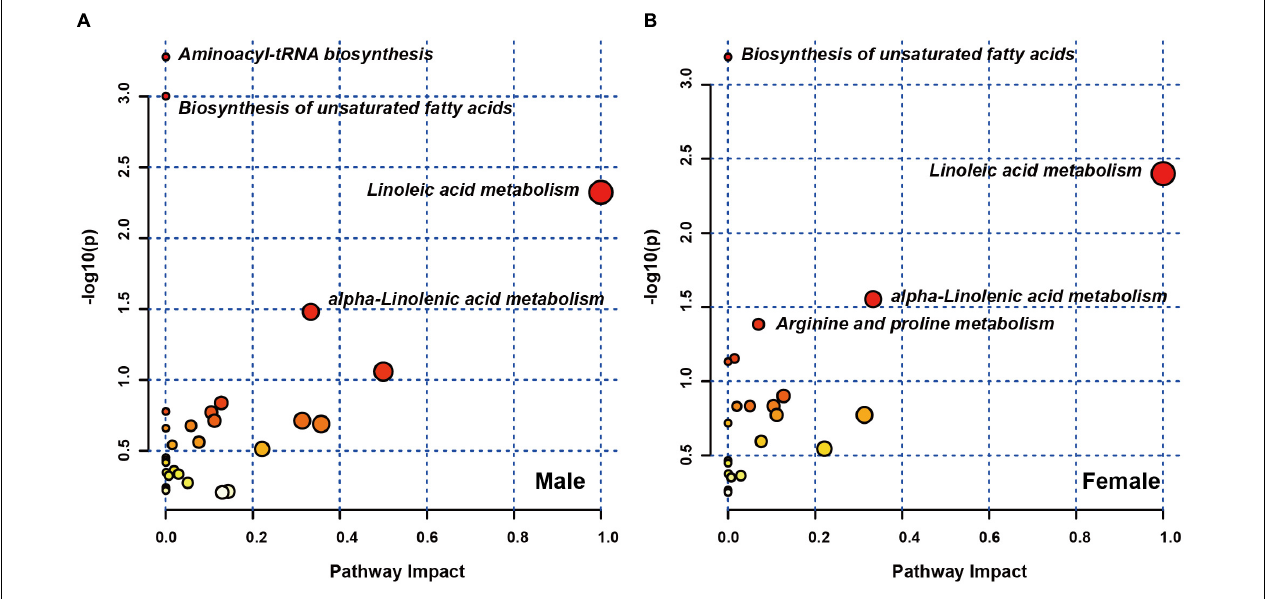
FIGURE 2 | Pathway analysis of sex differences in differential plasma metabolites. Metabolic pathway analysis plot displaying the four affected metabolic pathways in male (A) and female (B)